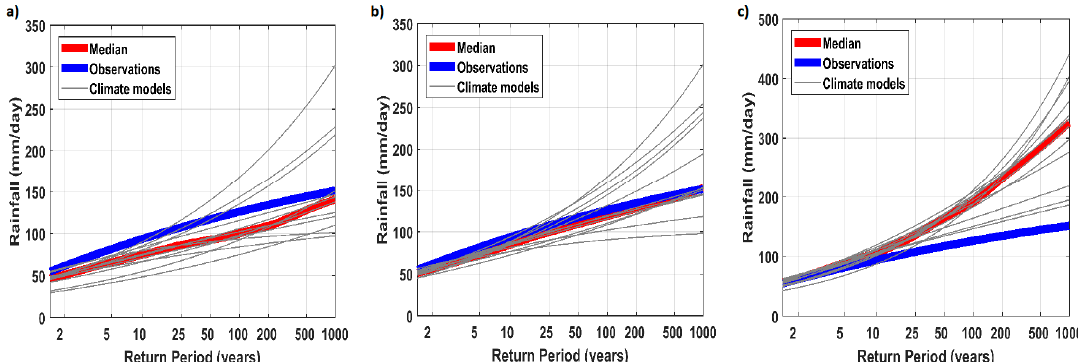
Figure 5. Annual maximum daily precipitation frequency curves in Camporredondo catchment. Blue lines are frequency curves fitted to observations. Red lines represent the median of the 12 climate models considered. ( a ) Raw precipitation supplied by climate models; ( b ) linear bias correction; ( c ) polynomial bias correction.